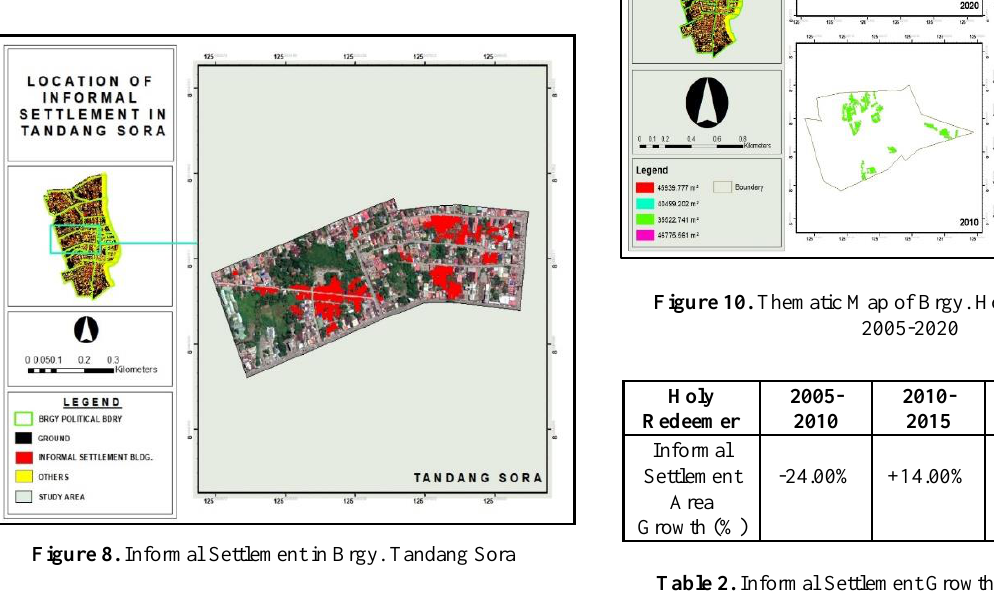
Figure 7. Informal Settlement in Brgy. San